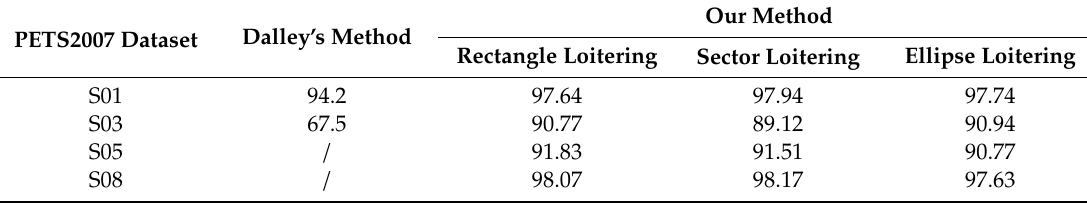
Figure 17. The detected results of the PETS2007 dataset. ( a , b ) The rectangle loiterer detection results in the same scene S01 but from different shooting angles. ( c ) The detected result for the S05 dataset using the sector loitering detection algorithm. ( d ) The results for the S03 dataset using the ellipse loitering detection algorithm. Table 4. Comparison of the detection accuracy (%) using the PETS2007 dataset.